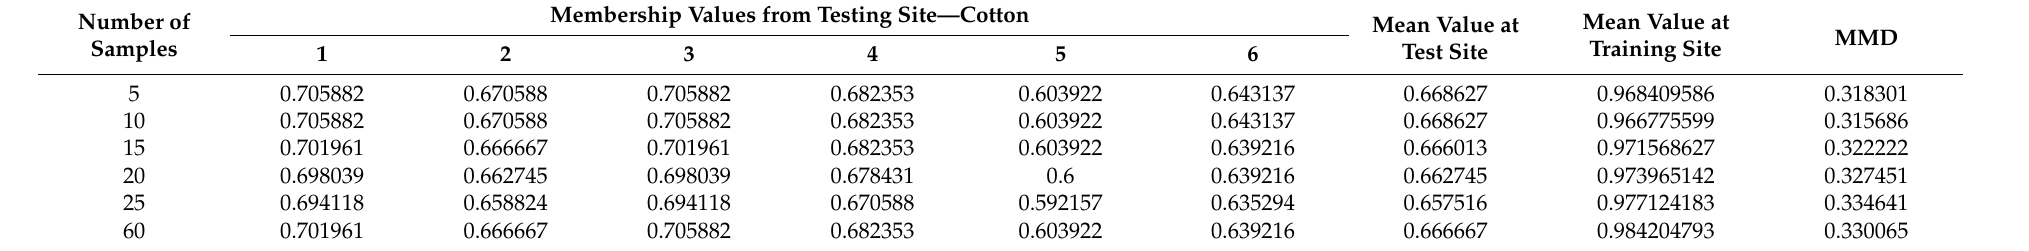
Table 10. Effect of increase in sample size by Comparing Membership values between Pigeon Pea Training fields and Cotton Test fields for separation—Mean training parameter based PCM classifier.